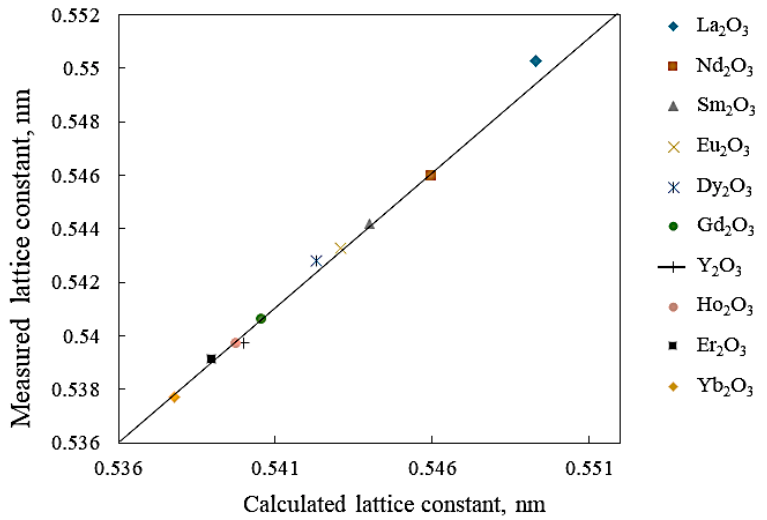
Figure 4 . Experimental and calculated lattice parameters of fluorite-structure CeO 2 solid solution containing variant rare earth sesquioxides [43].